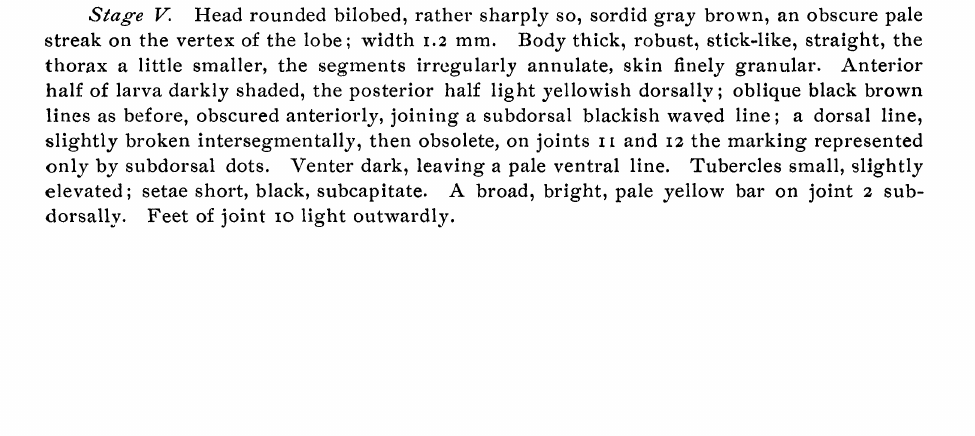
dorsally. Feet of joint o light